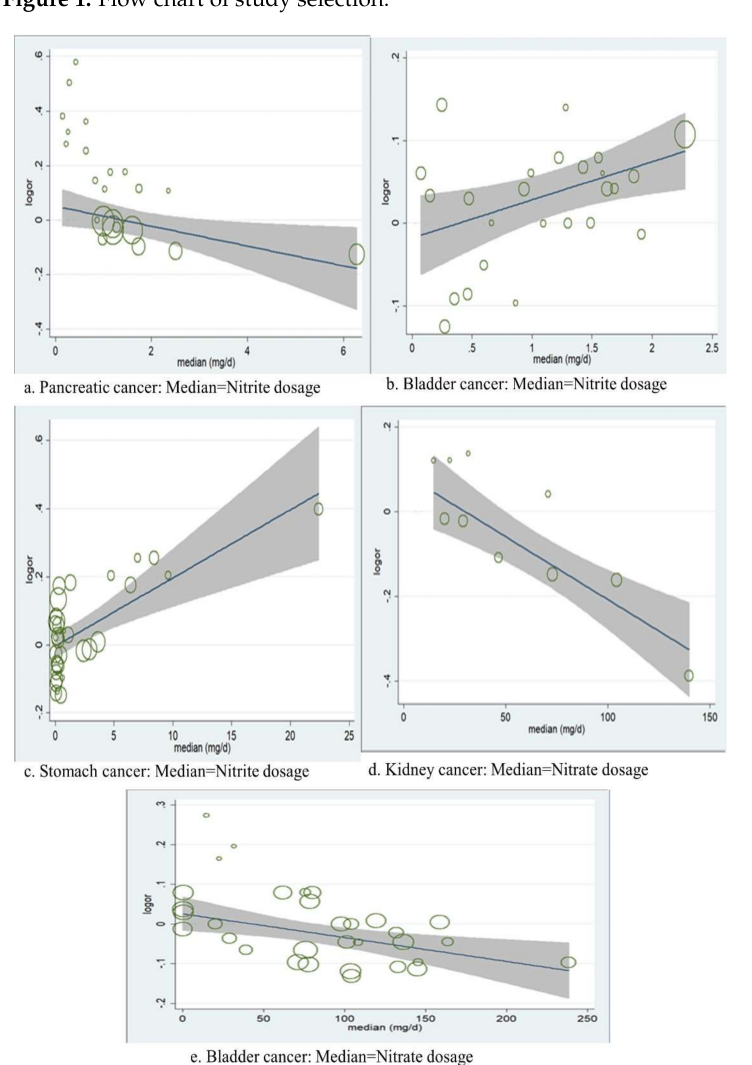
Figure 2. Meta-regression: the association between the risk of logarithm ORs and median dosage of dietary nitrite and nitrate for selected site-specific cancers; ( a ). Pancreatic cancer Median Nitrite dosage, ( b ). Bladder cancer: Median = Nitrite dosage, ( c ). Stomach cancer: Median = Nitrite dosage, ( d ). Kidney cancer: Median = Nitrate dosage, ( e ). Bladder cancer: Median = Nitrate